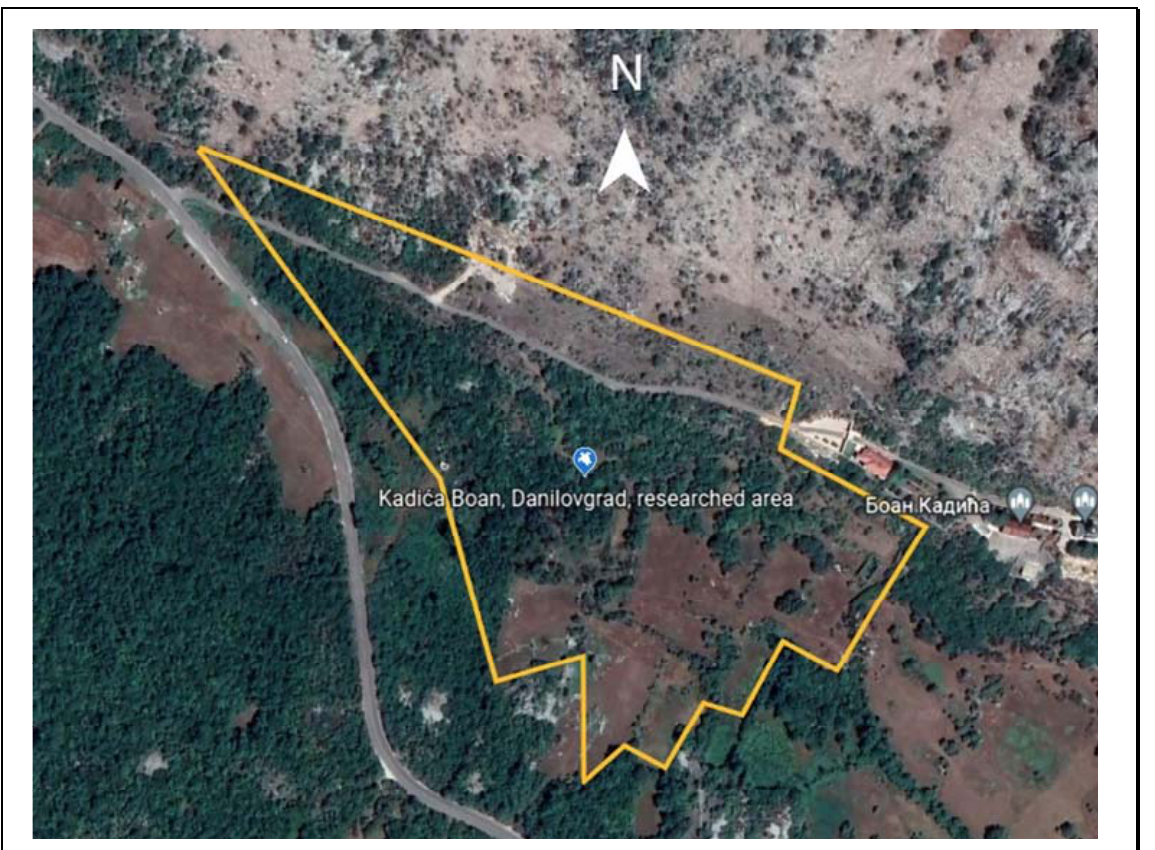
Figure 2. Map of the study area. Open area was mostly in the southern end and wooded (darker) areas to the north (Google Earth).